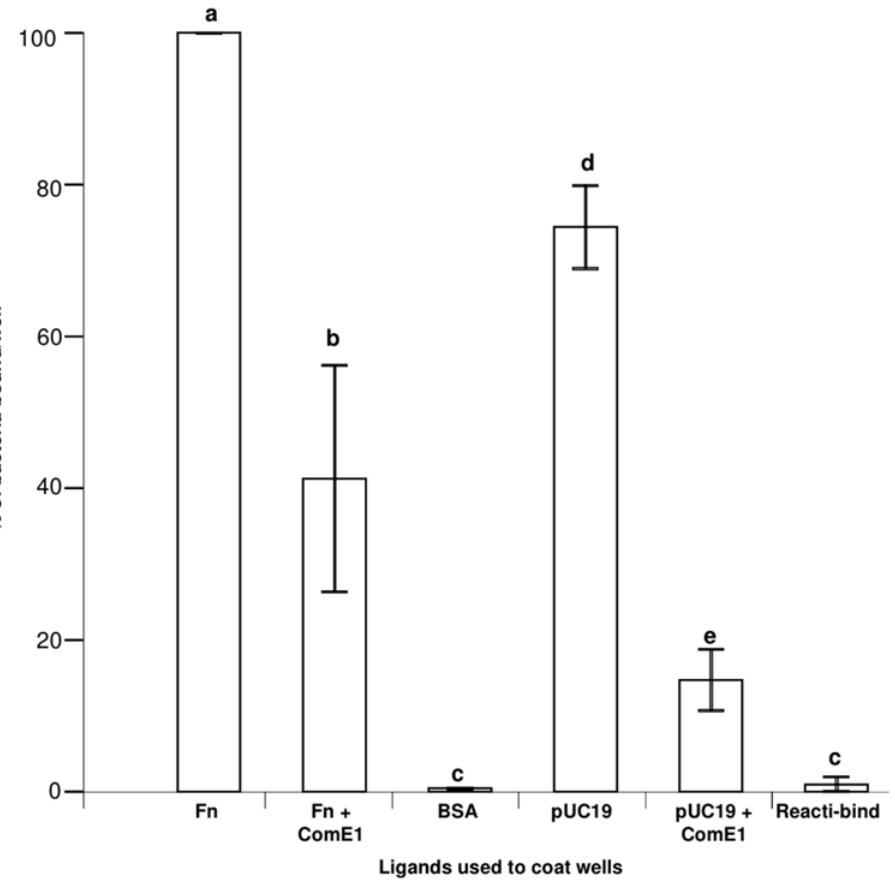
Figure 6. Binding of P.multocida to Fn or pUC19 pre-incubated with rGST-ComE1 from P.multocida . Values are expressed as percentage values of the binding to Fn. Bars with different letters are significantly different from each other (one-way ANOVA, P , 0.001). Data are the mean 6 SEM of triplicate wells. Results are representative of three separate experiments.